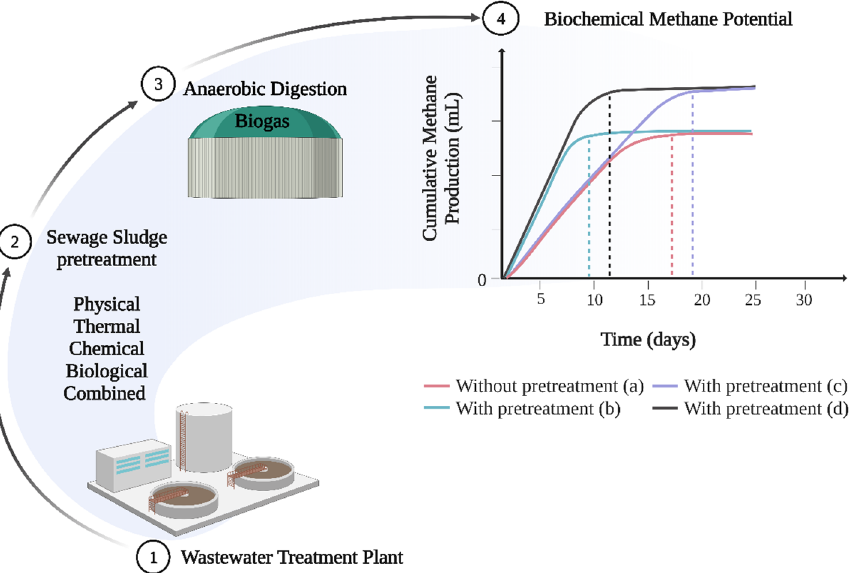
Figure 4. Pretreatment of sewage sludge to enhance anaerobic digestion efficiency and BMP typical outcomes associated with: (a) no additional benefits in case of untreated sludge (without pretreatment), (b) increased hydrolysis rate due to pretreatment, (c) methane production enhancement as consequent of pretreatment, (d) accelerated AD and increased methane production as a result of effective pretreat- ment. Dotted lines indicate the time point where the available organic matter has been bio-converted to